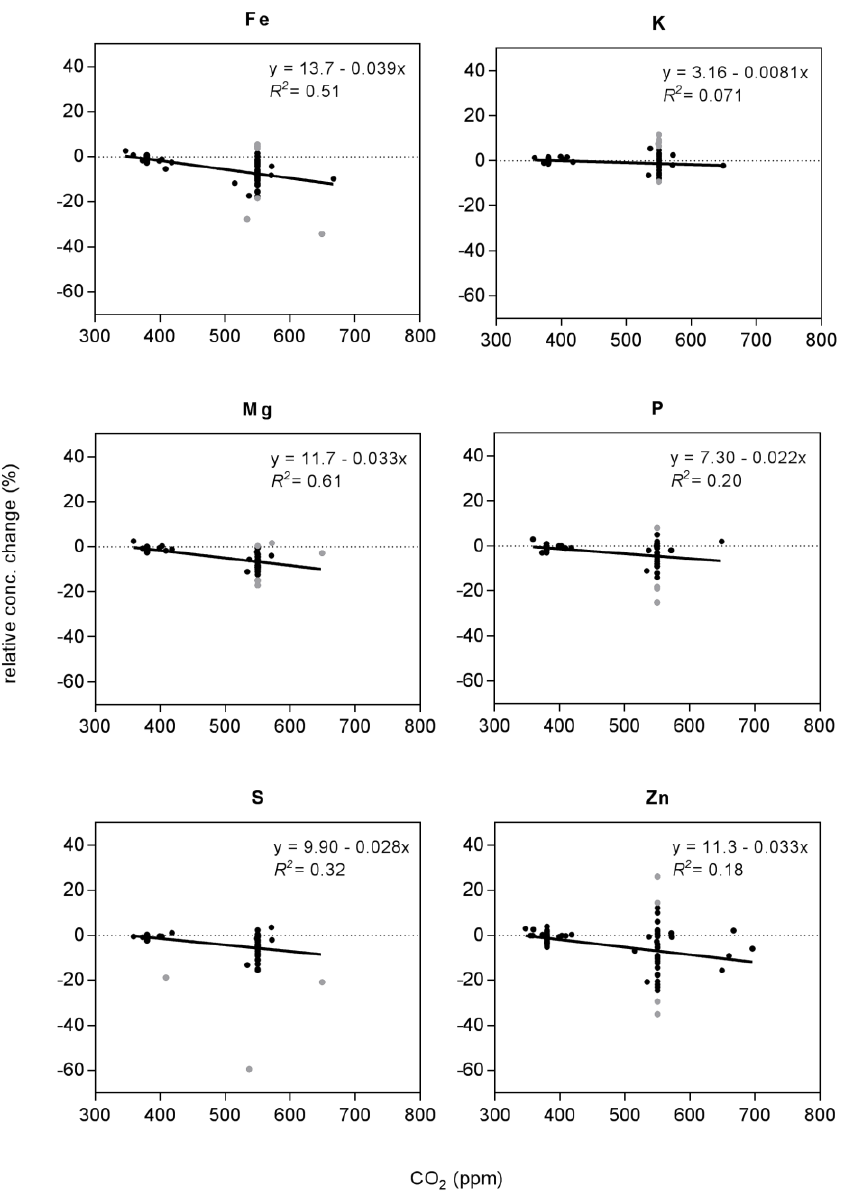
Figure 5. Response-functions for mineral concentrations of P, Mg, Fe, K, Zn, and S (relative to 350 ppm) with CO 2 concentration. Grey markers show data points identified as outliers and not included in the curve fitting.